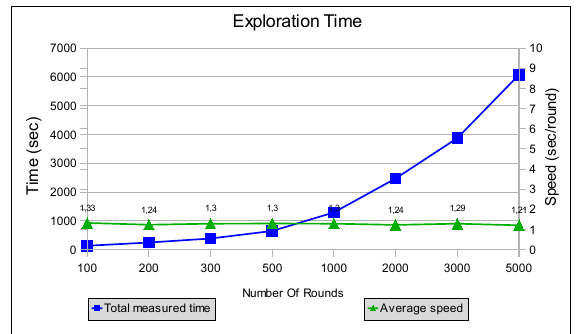
Figure 9. Average time for a scout agent to explore the